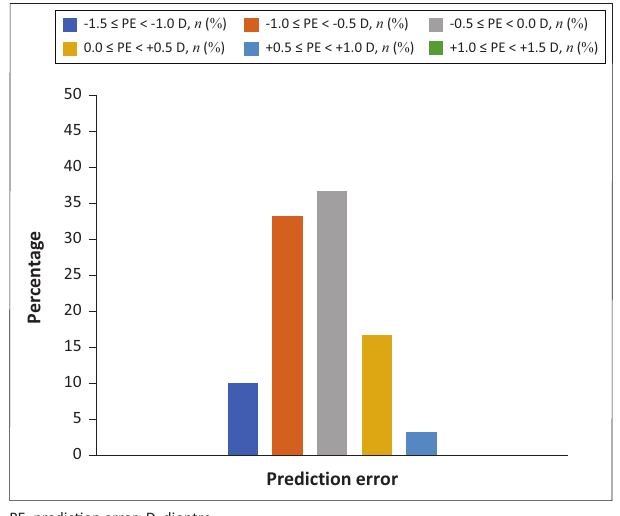
FIGURE 2: Percentage deviation of refractive outcome from predicted refraction in group 2.